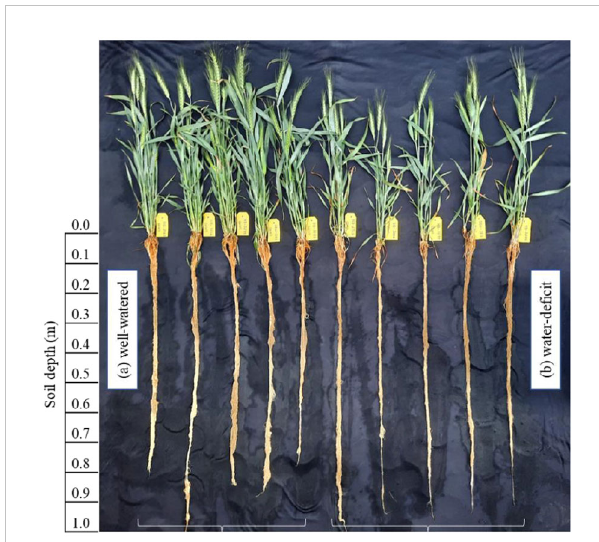
FIGURE 1 Destructively measured root growth pattern of the fi ve timely sown wheat genotypes (HD 2967, HD 3086, HD 3249, DBW 187, HD 3226) grown under well- (A) and de fi cit (B) watered conditions. Genotypes were sampled at the fl owering (Z61), 102 days of